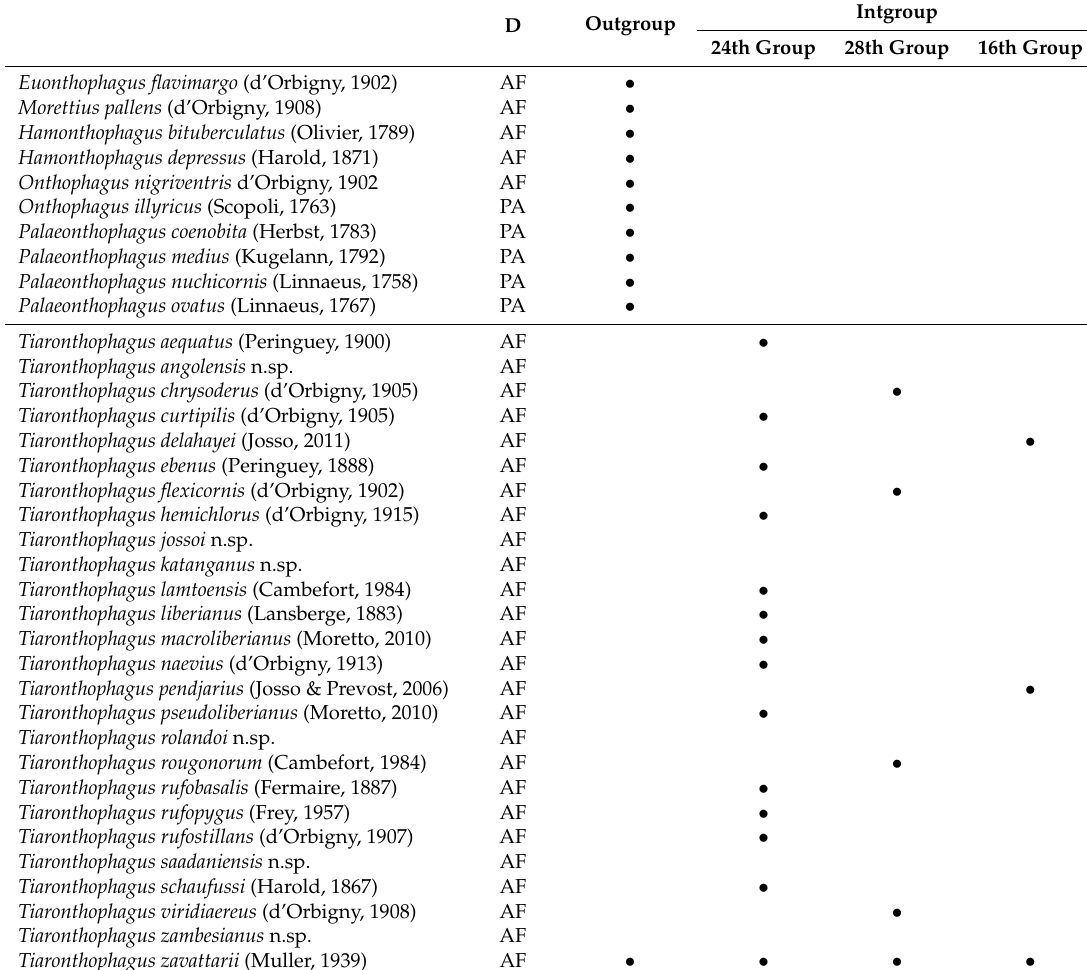
Table 1. List of the ingroup and outgroup species included in the analysis. The species were classified as Palearctic (PA) or Afrotropical (AF), according to their distribution (D). Part of the ingroup species were formerly included in three different d’Orbigny Onthophagus groups [2]: 14 in the 24th, four in the 28th, and two in the 16th group,